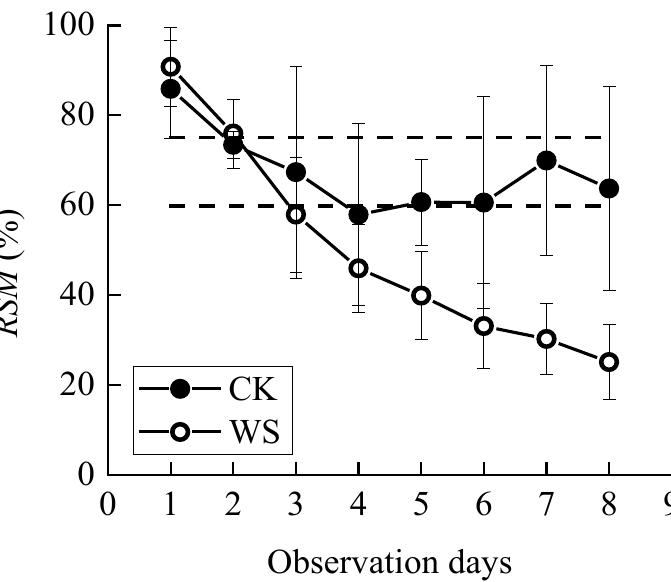
Figure 3. Changes in relative soil moisture ( RSM ) during the observation period. CK refers to the control group. WS refers to the continuous drought group. Circles represent means, and error bars show standard deviations ( n = 4). The dashed line represents the 95% confidence intervals for the mean of CK.